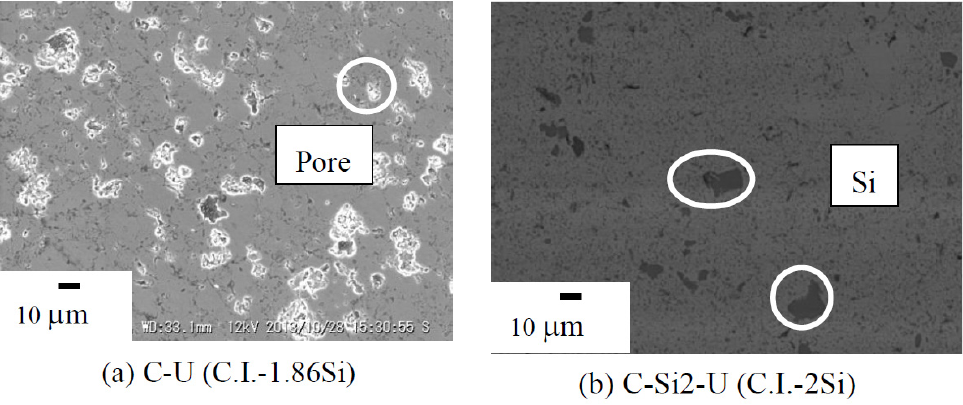
Figure 4. SEM microstructures of the annealed C-U (C.I.-1.86Si) and C-Si2-U (C.I.-2Si) samples at 900 °C for 5